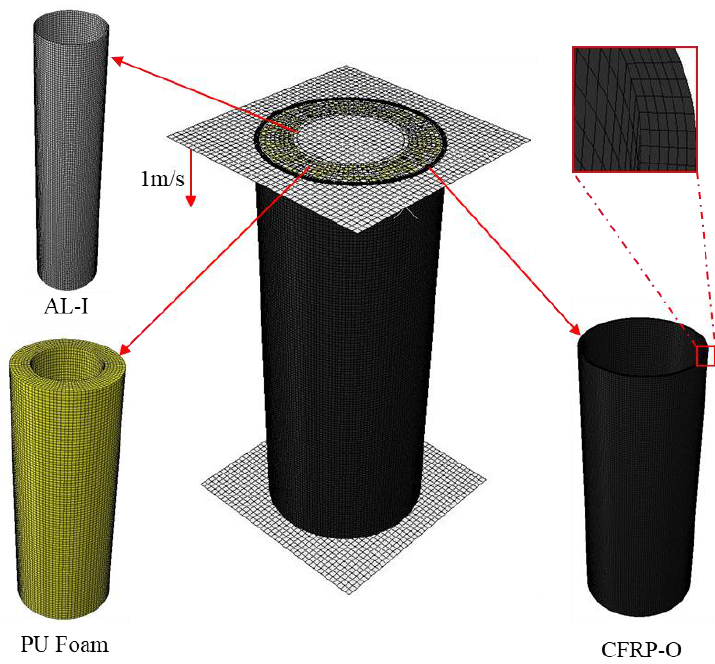
Figure 4. The FE model of the hybrid specimen C-PU-AL (polyurethane foam filler between outer CFRP tube and inner aluminum tube) and individual components.